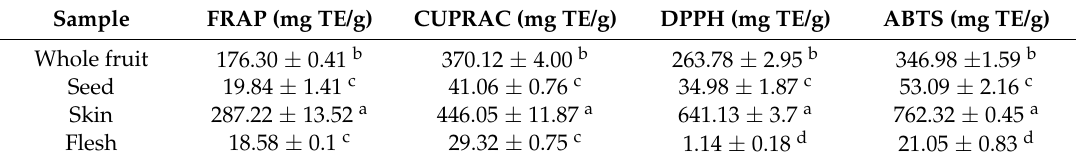
Table 3. Antioxidant capacity of Tuckeroo fruits.